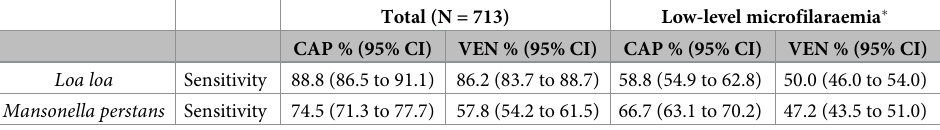
Table 6. Diagnostic sensitivity of capillary and venous blood to detect a microfilaraemia using